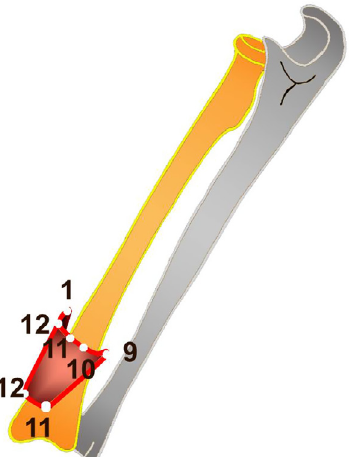
Figure 5. Reference positions for maximal range of motion in the radius. Level VII positions 9–12, 1. Level VIII, positions 11, 12,